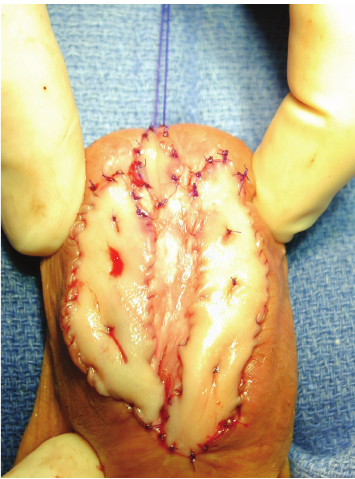
Figure 3: First-stage urethroplasty with buccal grafts.